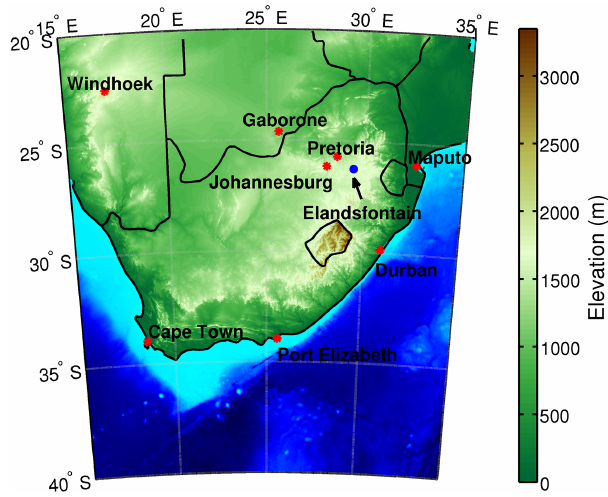
Figure 1. Map of South Africa and the location (26 ◦ 14 (cid:48) 43 (cid:48)(cid:48) S, 29 ◦ 25 (cid:48) 30 (cid:48)(cid:48) E) of the Elandsfontein measurement station on the South African Highveld. The figure is based on the ETOPO1 bedrock data set (Amante and Eakins, 2009).